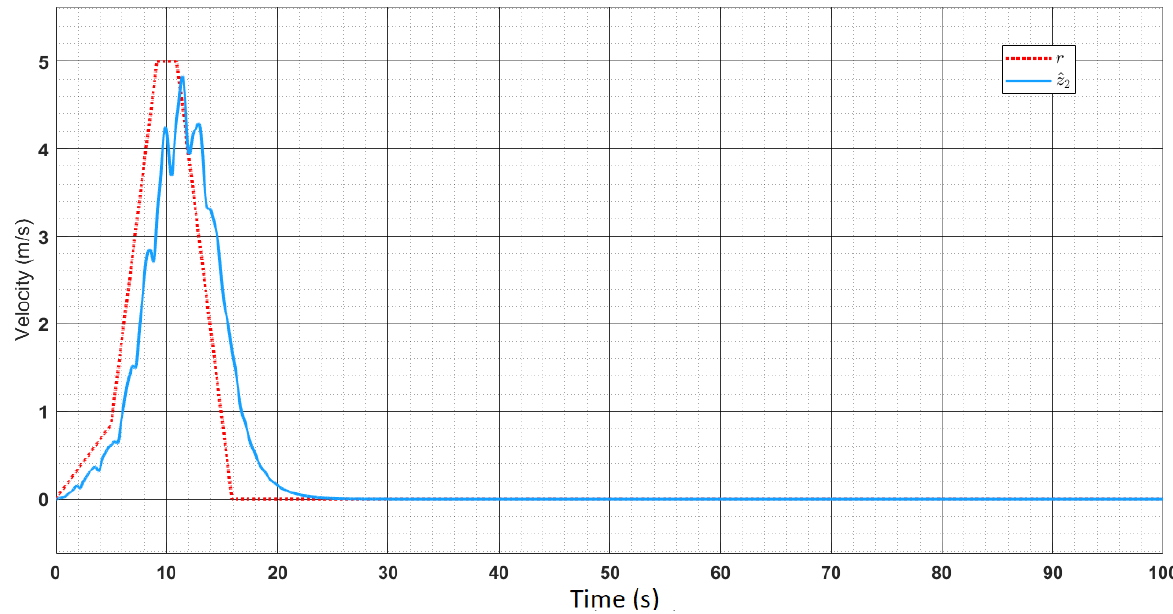
Figure 24. Comparing reference input velocity and actual velocity